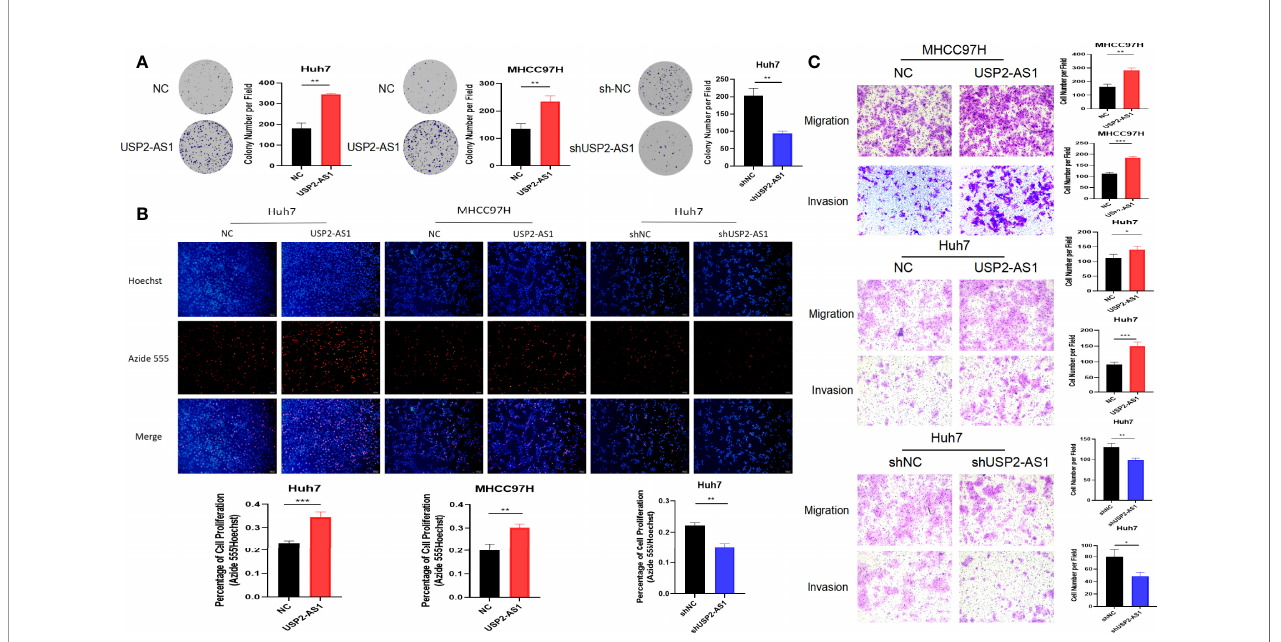
FIGURE 2 | USP2-AS1 promotes HCC proliferation, migration, and invasion under hypoxia in vitro . (A) The effect of USP2-AS1 on the clonogenic capacity of HCC cell lines Huh7 and MHCC97H in vitro was veri fi ed under hypoxia. (B) EdU cell proliferation assays con fi rmed USP2-AS1 affected the proliferative capacity of hepatoma cell lines Huh7 and MHCC97H, under hypoxia, in vitro . (C) Overexpression or knockdown of USP2-AS1 under hypoxic conditions affected the migration and invasion ability of HCC cell lines Huh7 and MHCC97H in vitro . Two-tailed Student ’ s t-test, *p < 0.05, **p < 0.01, and ***p <